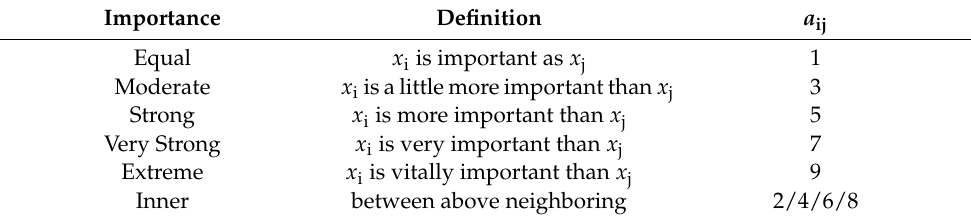
Table 4. 1–9 ratio